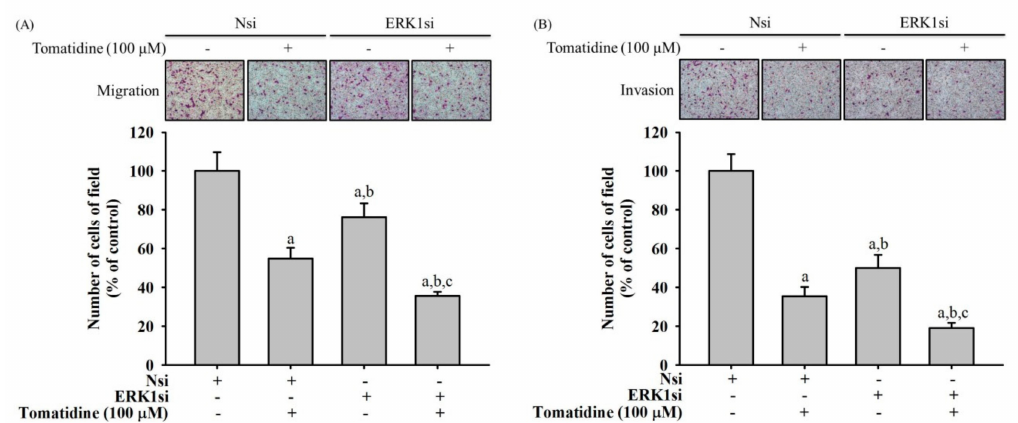
Figure 6. E ff ects of ERK 1 knockdown on biological behaviors of migration and invasion in tomatidine-treated U2OS cells. Using siRNA directly against the ERK 1 expression, modified Boyden chamber assays ( A ) without and ( B ) with Matrigel coating after treatment of PS-1 siRNA for 48 h in U2OS cells with or without treatment of 100 µ M tomatidine were conducted. Results are shown as mean ± S.D. n = 3. ANOVA analysis with Turkey’s posteriori comparison was used. ( A ) F =